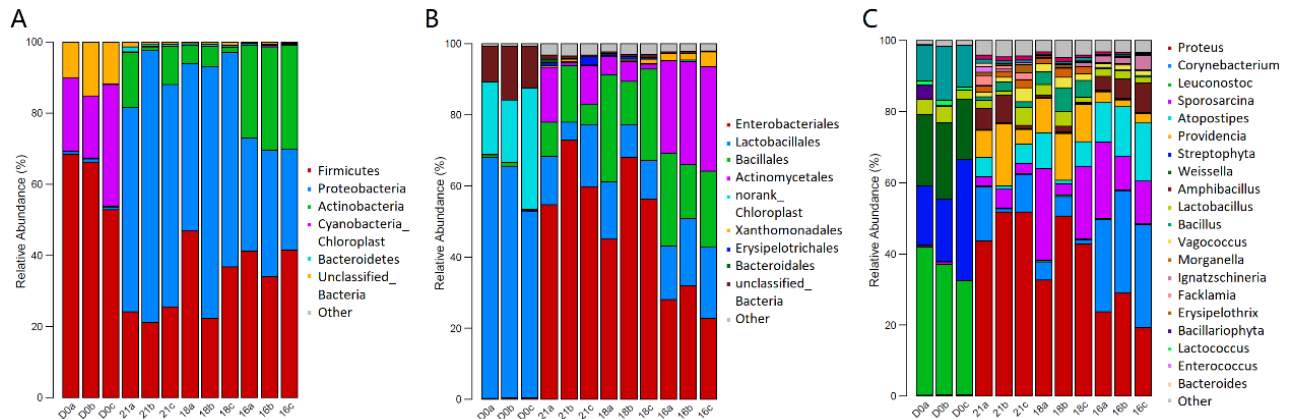
Figure 9. The bacterial community of food waste (d 0) and larval frass (d 10). A, the phylum level; B, the order level; and C, the genus level. D0, food waste; 21, frass of C/N21:1; 18, frass of C/N18:1;